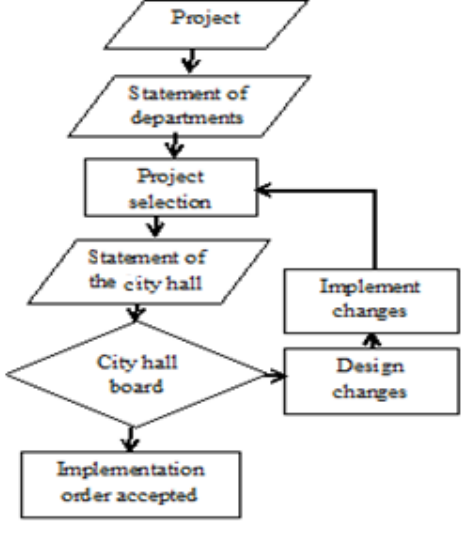
Figure 1. Process flow of project selection Source: own